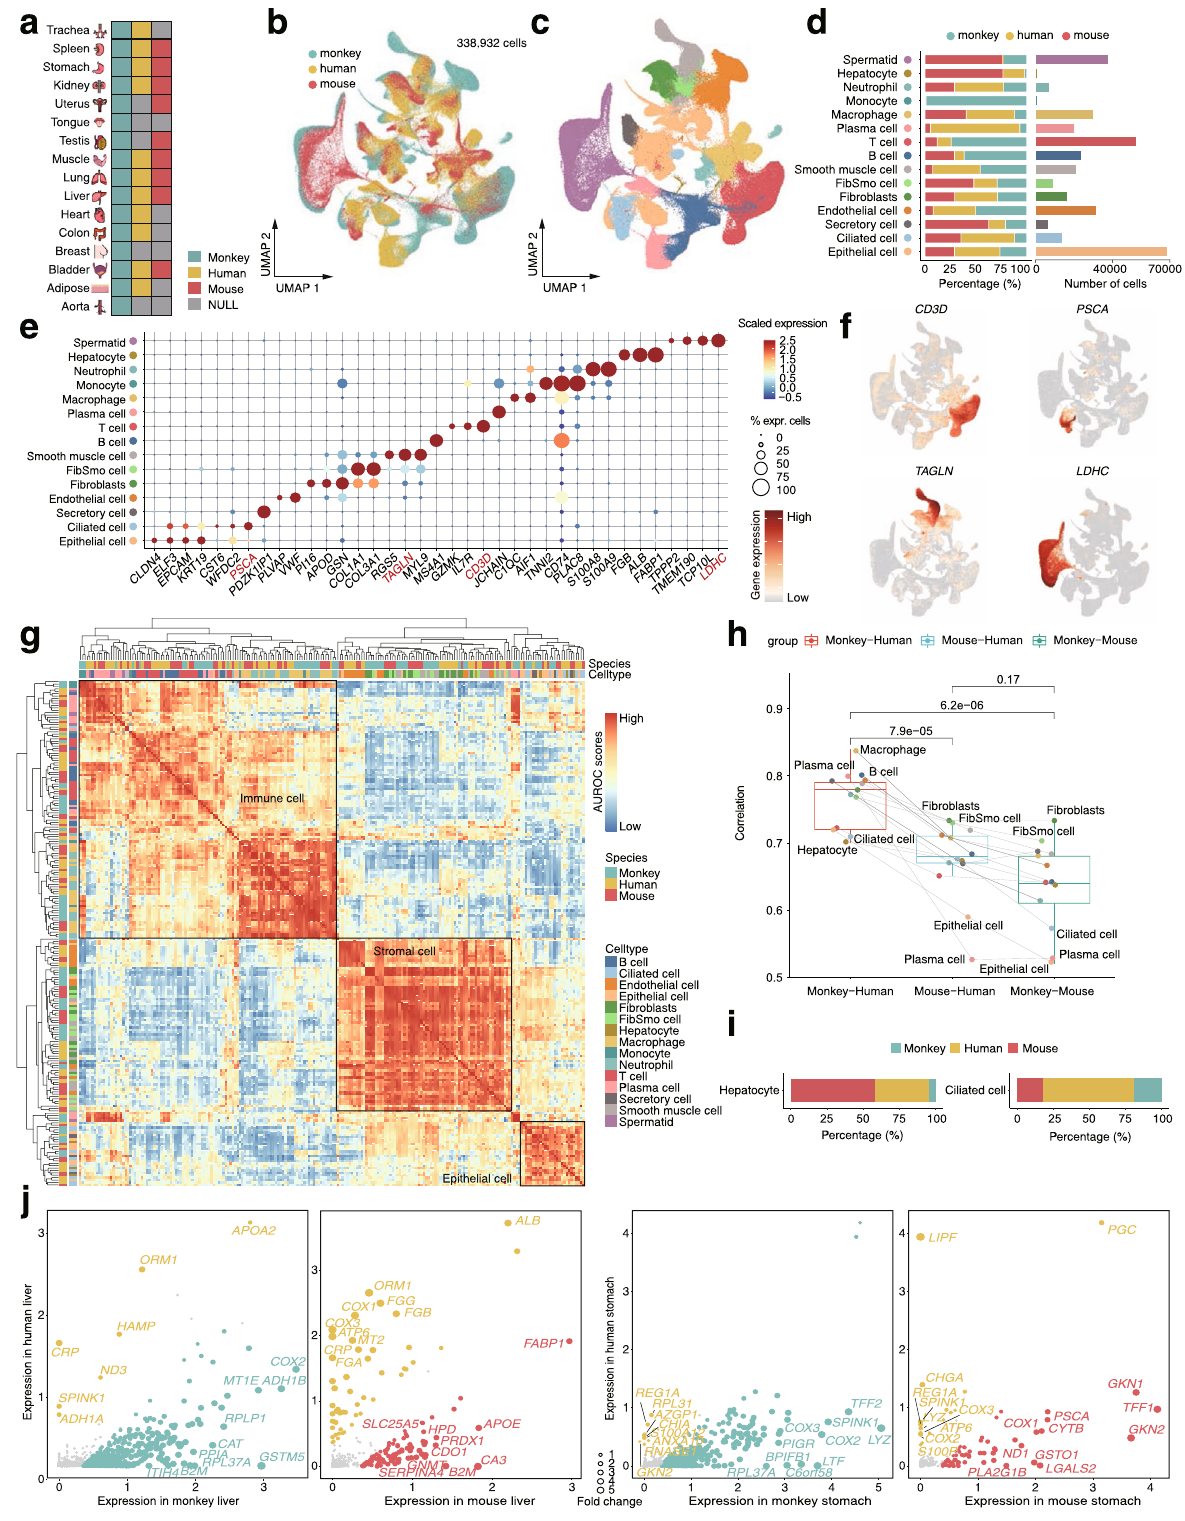
the eight samples in seven different organs provided in our study is a well complement to the cynomolgus monkey